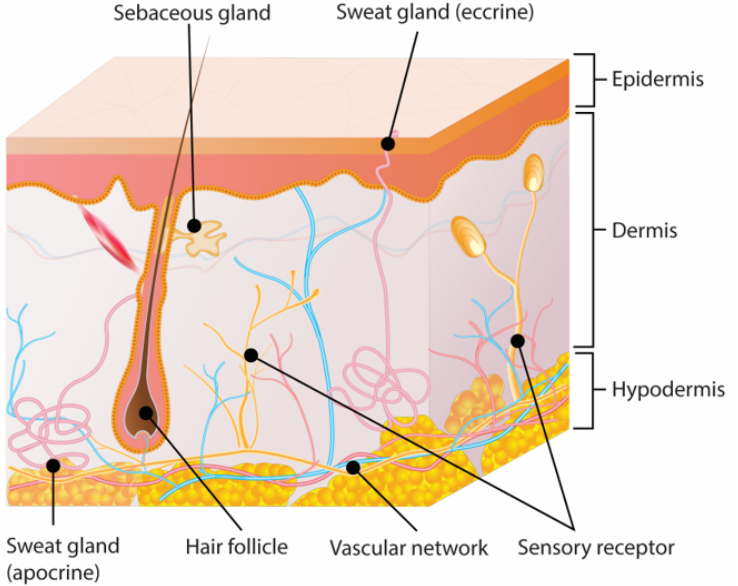
Figure 1. Histological structure of skin.